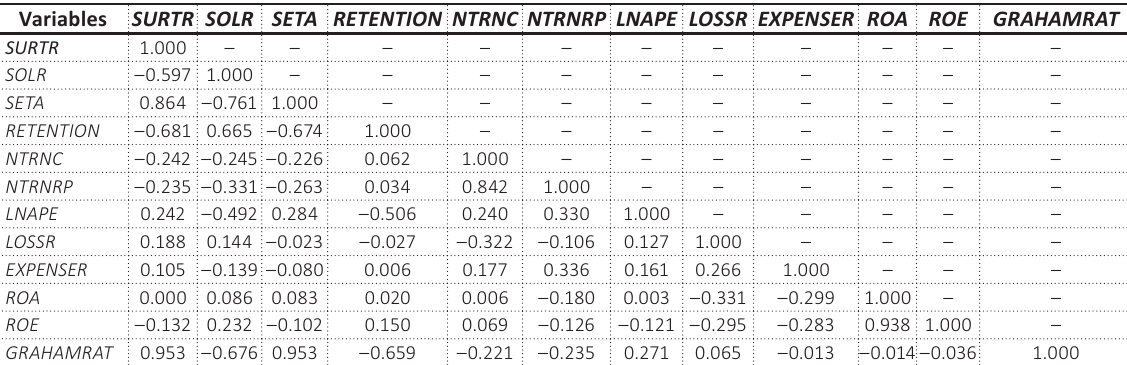
Table 3. Correlation